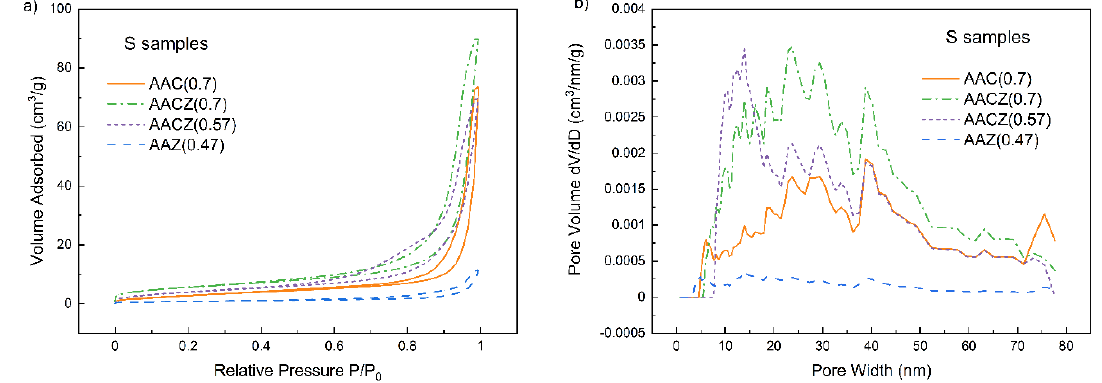
Figure 6. Adsorption/desorption isotherms ( a ) and pore size distributions ( b ) of S samples determined by N ₂ physisorption. Table 4. Surface area S BET and pore volumes of